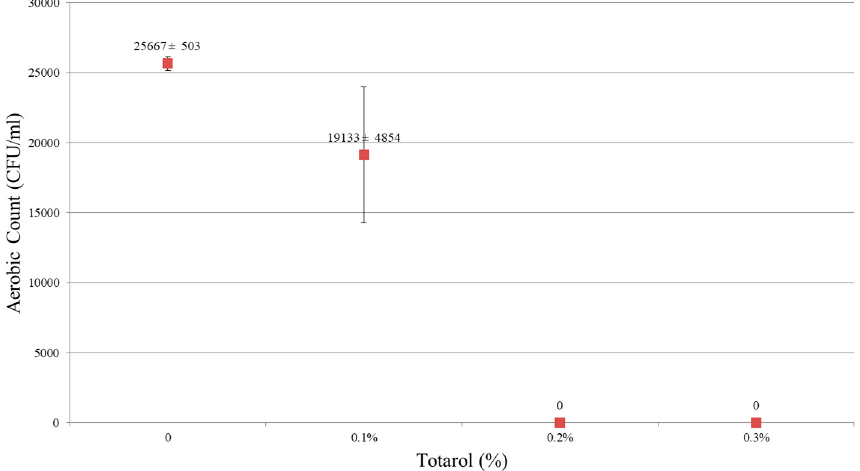
Figure 1. Effect of totarol level on aerobic counts.